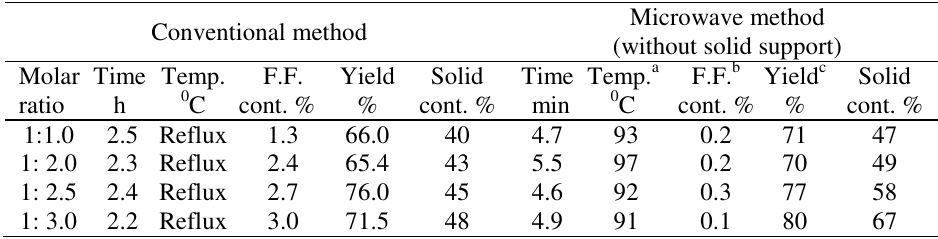
Table 1. Comparative study for the synthesis of melamine-formaldehyde resin Conventional and microwave irradiation method (without solid support)